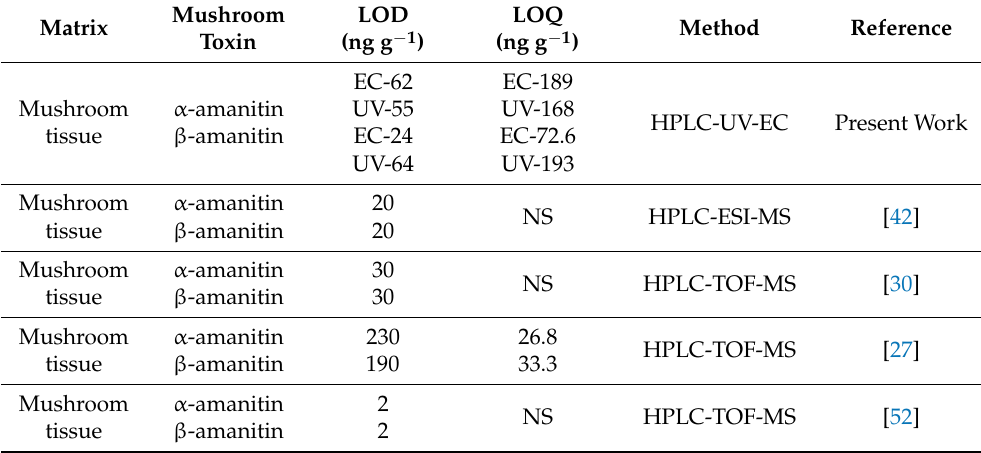
Table 2. Limits of detection for direct mushroom